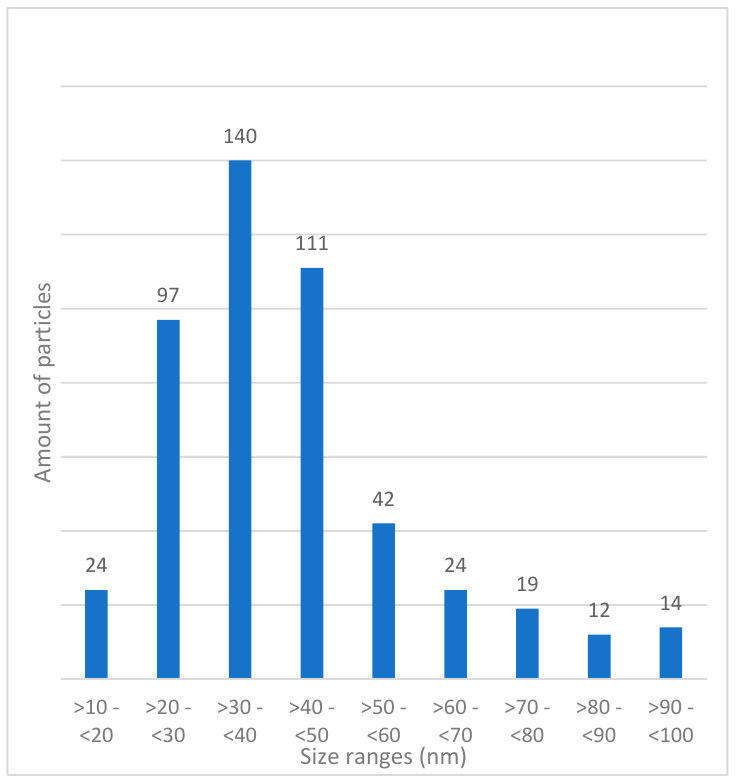
Figure 11. Histogram of sizes obtained in TEM. On the X-axis, we have size ranges (nm), and on the Y-axis, we have the number of particles.